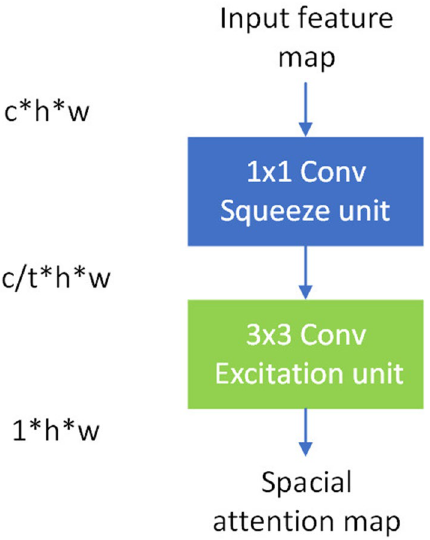
Figure 4. Flowchart of the spatial attention unit. t is the compression